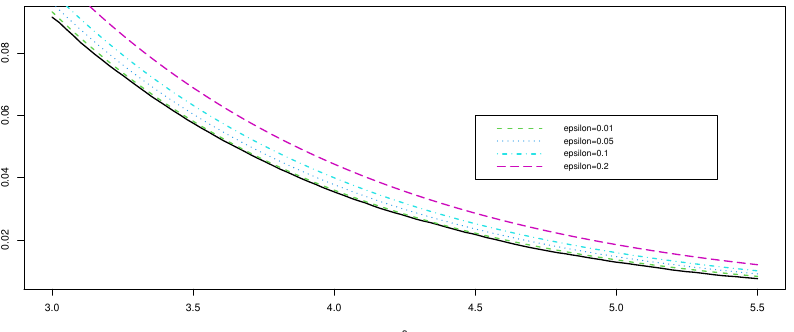
Figure 2. Exact and approximate tail probabilities of the empirical spatio-temporal estimator with contamination (cid:101) = 0.01, (cid:101) = 0.05, (cid:101) = 0.1 and (cid:101) = 0.2, with sample size n ( h , τ ) =